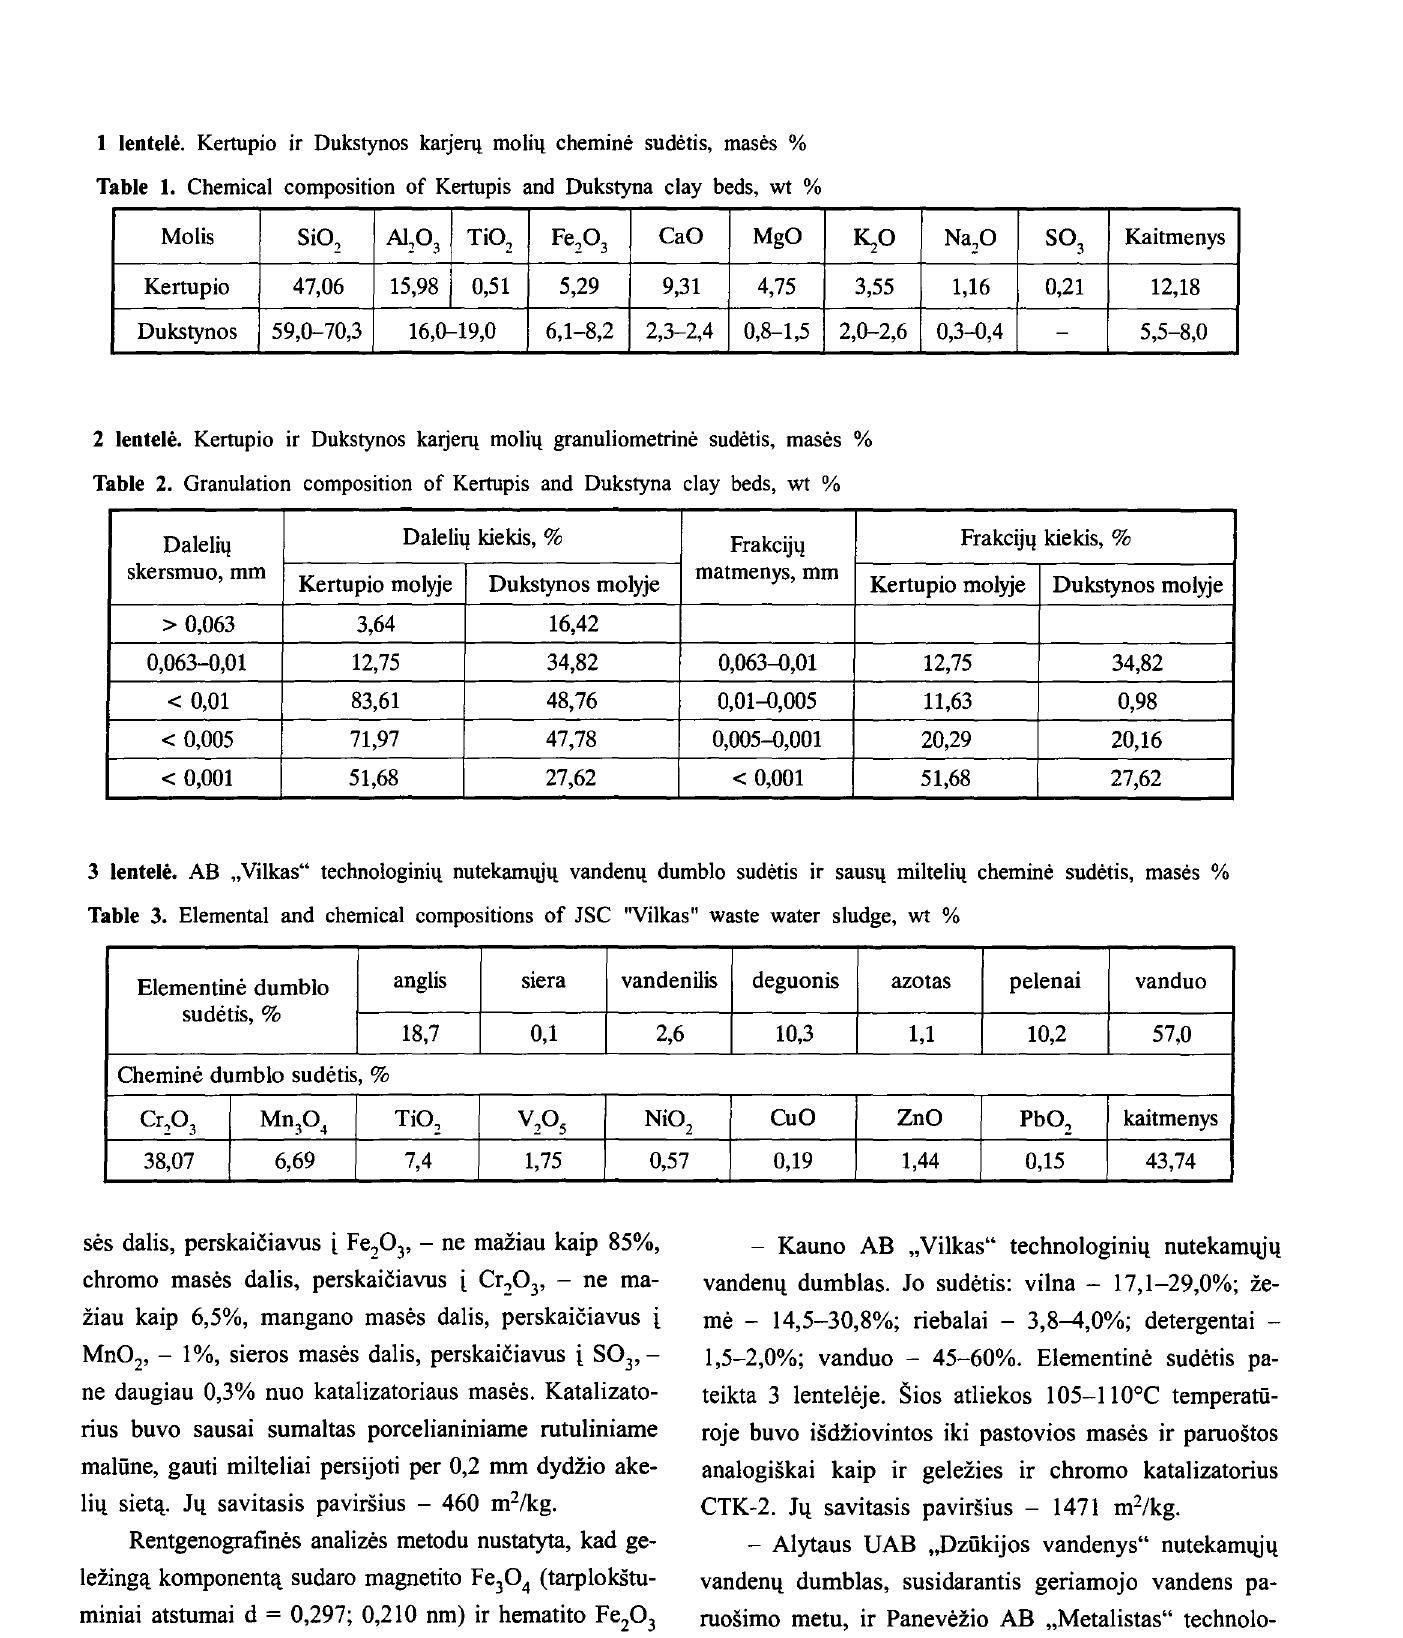
Table 1. Chemical composition of Kertupis and Dukstyna clay beds, wt % Molis Kertupio